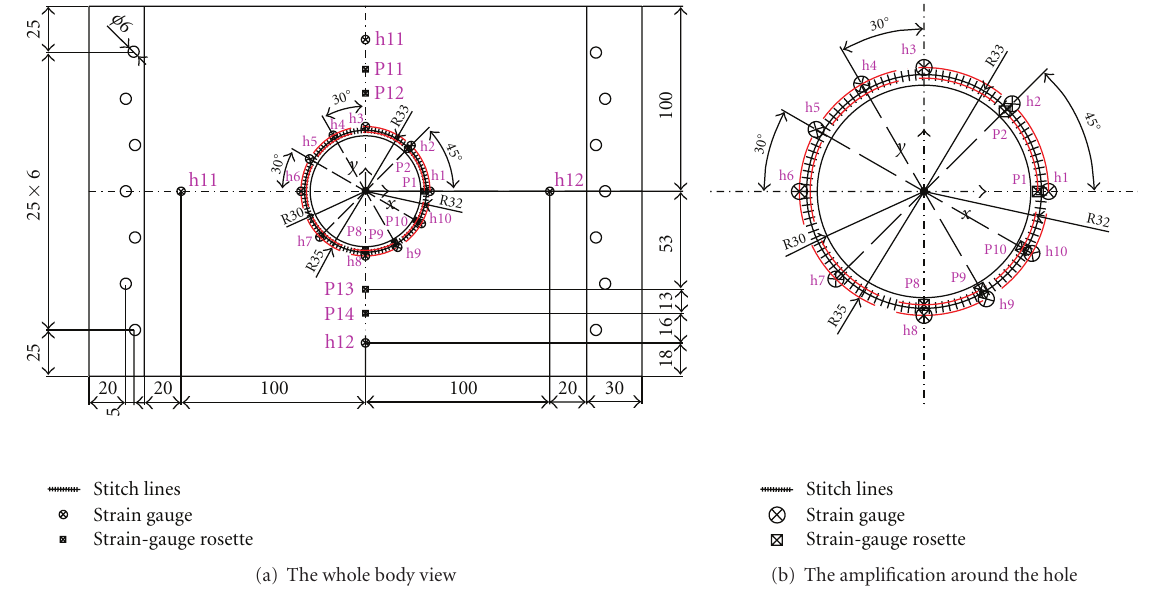
Figure 2: Location of strain gauges attached on the single-line stitching panel (mm).